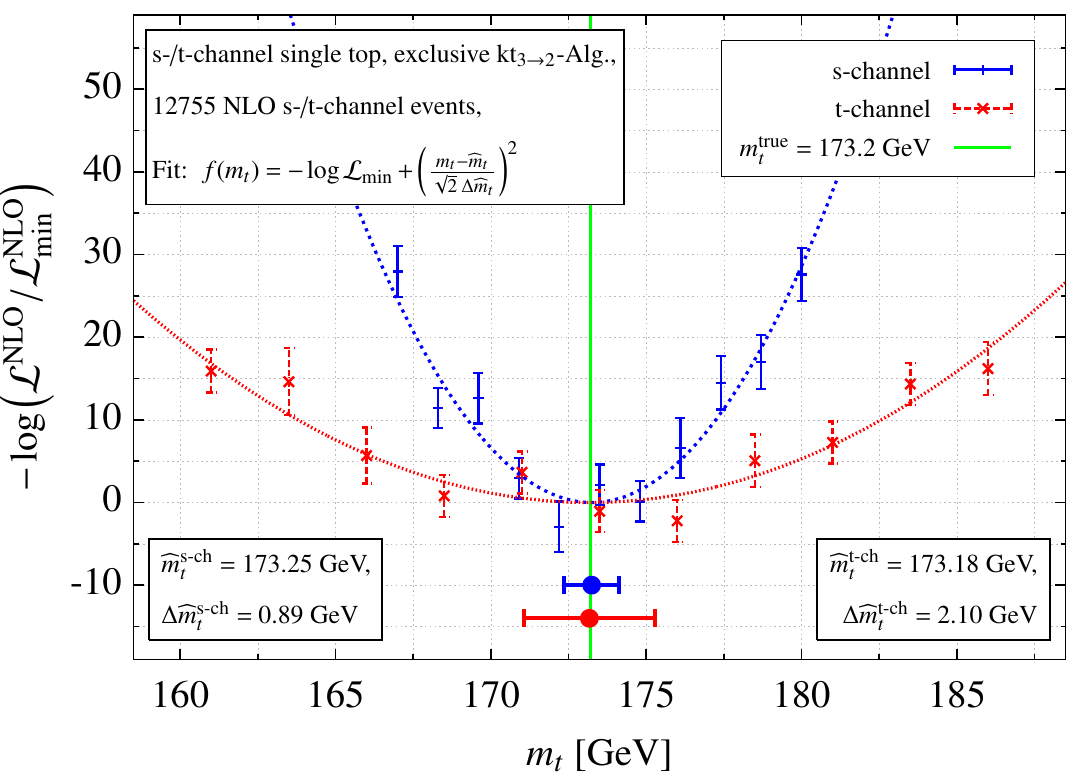
Figure 19 . Extraction of the top-quark mass for a (cid:12)xed number of NLO s - and t -channel single top-quark